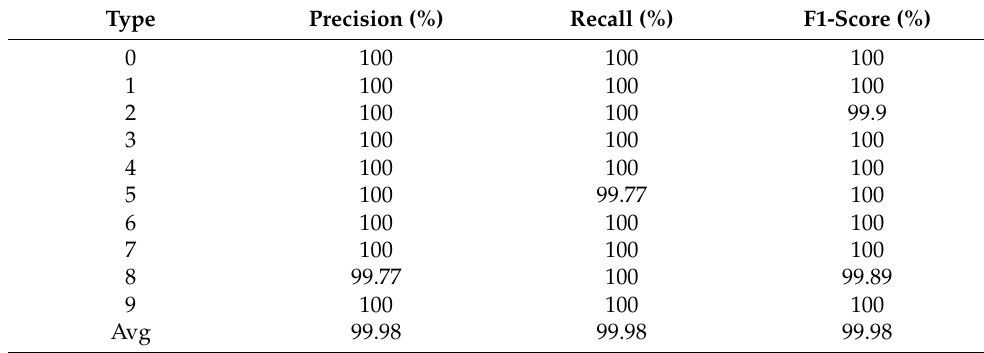
Table 4. The diagnosis result evaluation of improved 1DCNN.